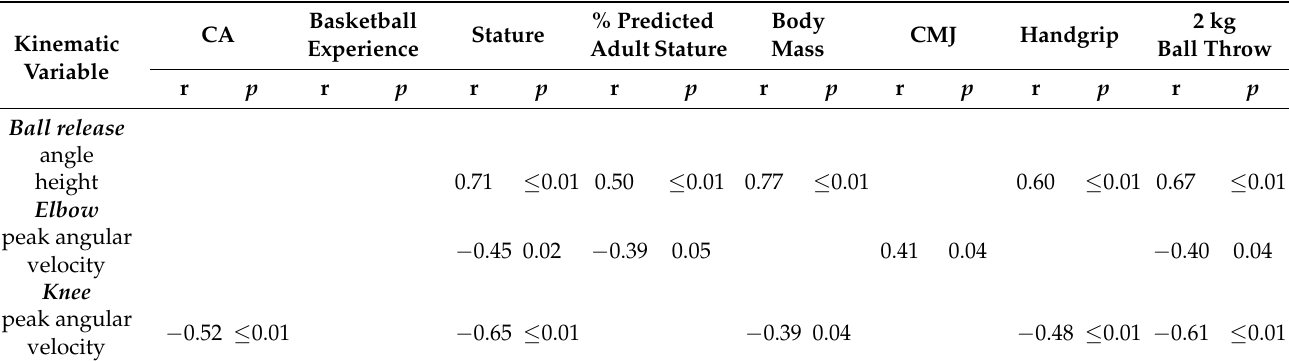
Table 3. Significant results according to the Pearson product coefficient correlations between selected kinematic parameters while performing with ball size five, anthropometry, and fitness tests.